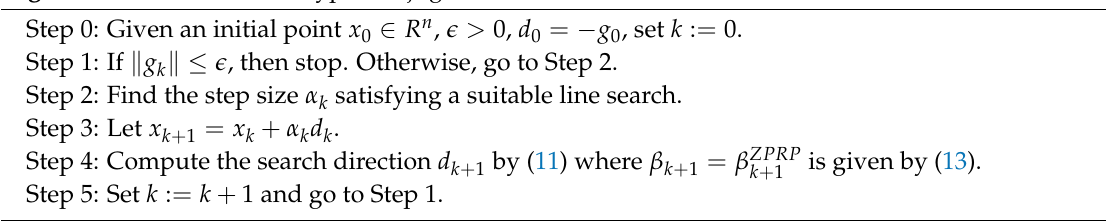
Algorithm 1 Modified PRP-type Conjugate Gradient